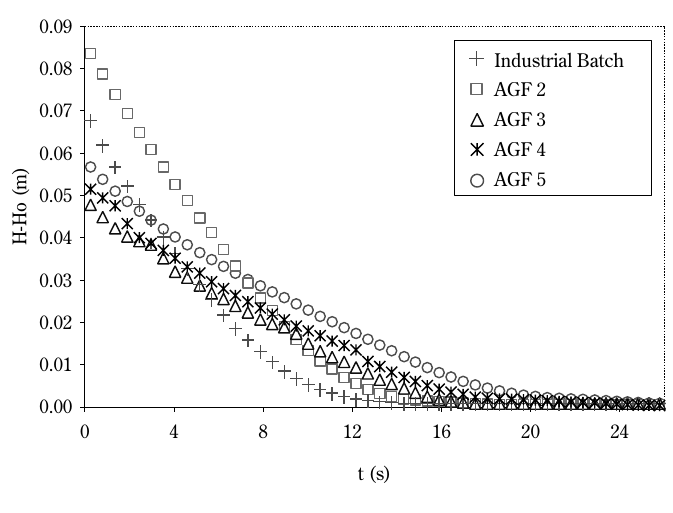
Fig. 14 Bed collapse curves